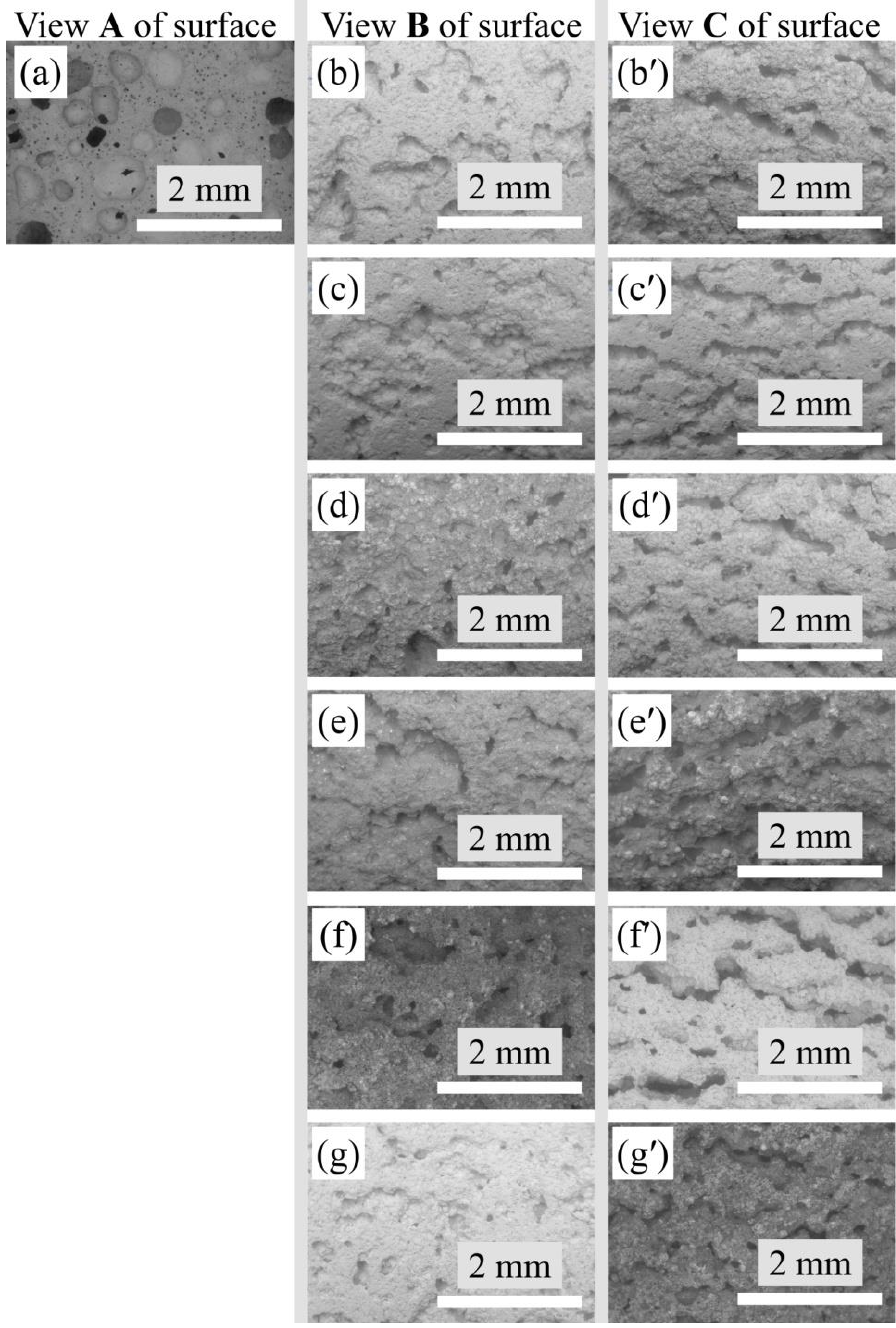
Figure 3. TableTop SEM micrographs illustrating the macrostructure of the investigated samples, magnification ×20: ( a ) view A of the undoped sample surface; ( b – g ) view B of the modified sample surface perpendicular to the base of the molds; ( b ’ – g ’ ) view C of the modified sample surface parallel to the base of the molds; ( b , b ’ ) samples with YSZ; ( c , c ’ ) with MSZ; ( d , d ’ ) with YSZ:WO 3 (1:1); ( e , e ’ ) with MSZ:WO 3 (1:1); ( f , f ’ ) with YSZ:WO 3 (1:2); and ( g , g ’ ) with MSZ:WO 3 (1:2).